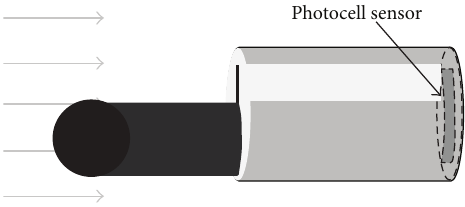
Figure 2: Positions sensor operation.